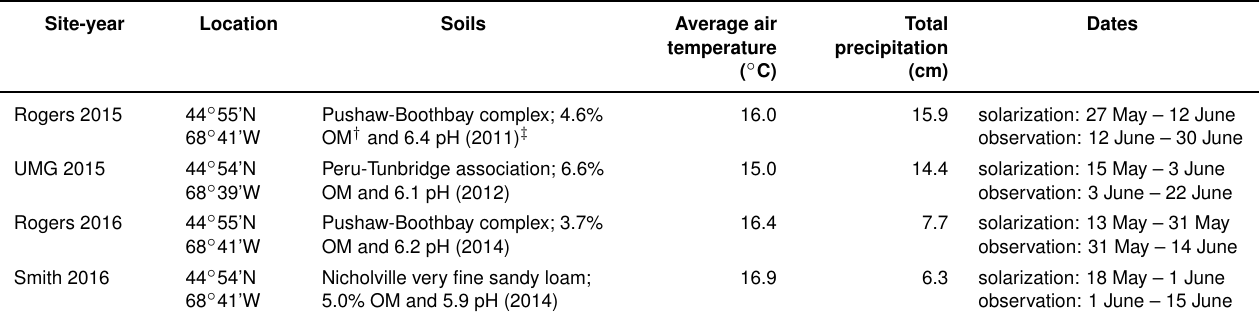
Table 1. Location, soils, weather, and dates for solarization field